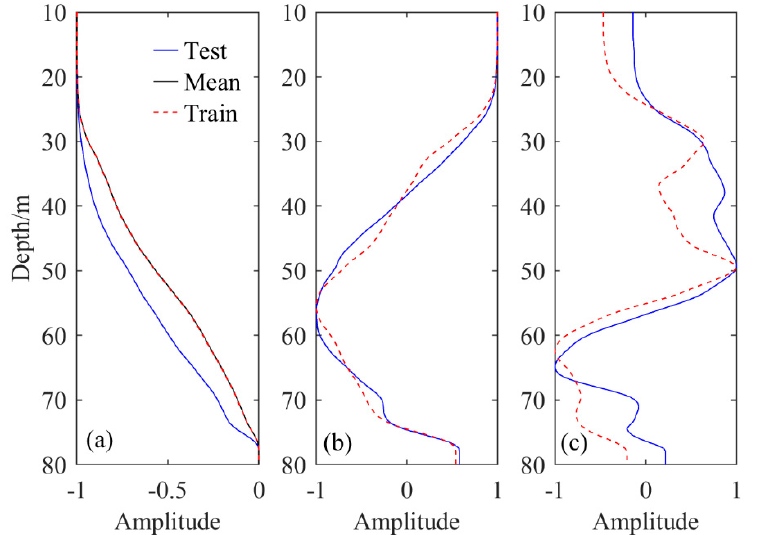
Figure 4. Normalized background field modes and first two EOF modes, ( a ) The background field modes extracted from the training set and the test set and the normalized mean temperature profile of the training set, ( b ) the first EOF modes from the training set and the test set, ( c ) the second EOF modes extracted from the training set and test